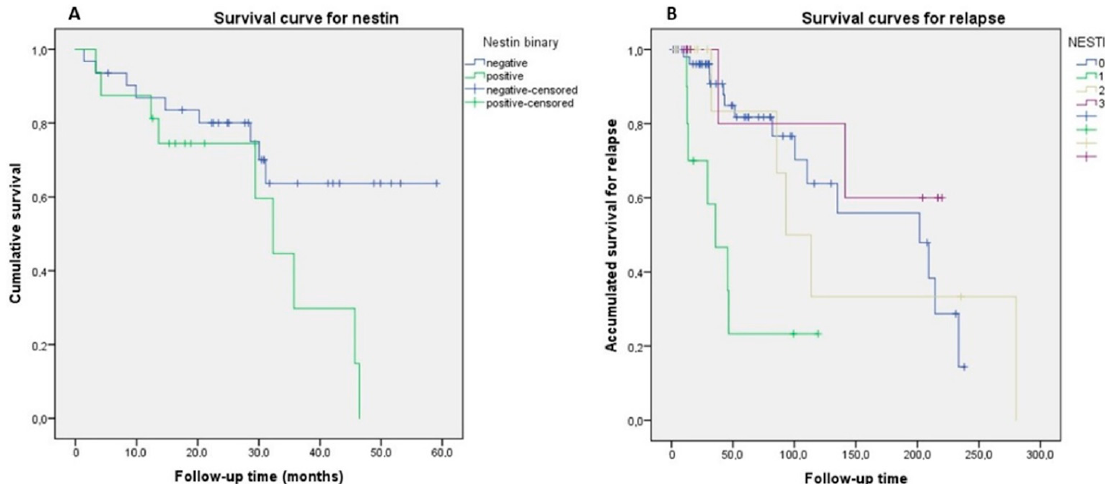
Figure 3. ( A ) Kaplan Meier survival curve designed by excluding pleomorphic adenomas and considering nestin immuno- histochemical expression during the first 5 years of follow-up. ( B ) Kaplan Meier survival curve for relapse based on fully graded nestin expression. By means of Cox regression, we verified that the Hazard Ratio for grade 1 expression is 4.577 (confidence interval (CI): 95% 1.802–11.626, p = 0001). For a model adjusted by location, sinus lesions are protective for recurrence (hazard ratio (HR) = 0.210, CI: 95% 0.070–0.627, p = 0.005) (Table 3). Table 3. A univariate logistic regression analysis was performed to determine the univariate hazard ratio (HR) for Relapse. The statistical analysis of the adjusted HR was performed using gradual Cox Regression Analysis adjusted for Nestin expression and location.